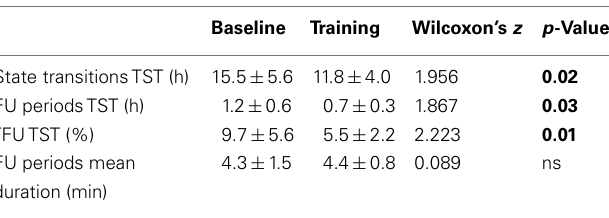
Table 3 | Sleep stability.